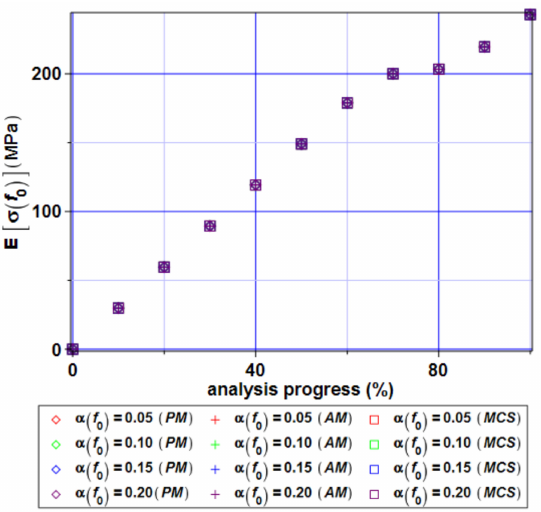
Figure 23. Expectations of the extreme von Mises stress E[ σ (f 0 )] for the beam.